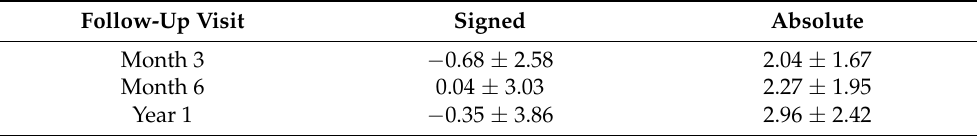
Table 2. Average absolute and signed off-axis rotation 3 months and 1 year following IOL implantation 1 . Follow-Up